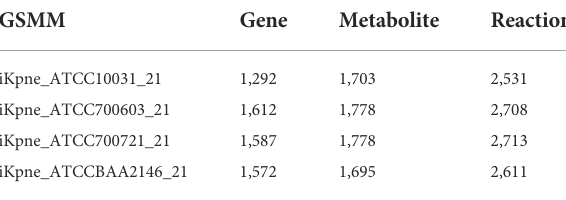
TABLE 2 Total number of genes, metabolites, and reactions in the constructed